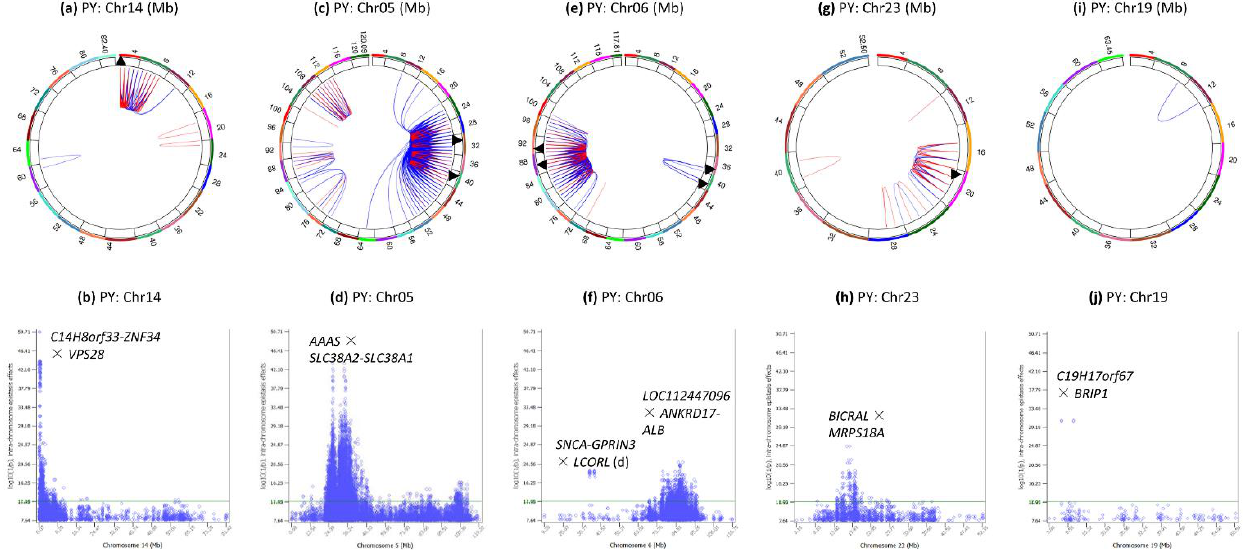
Figure 6. Chromosomes with most significant intra-chromosome epistasis effects for protein yield. The top row shows the circular plots with red color indicating intra-4 Mb epistasis effect and blue color indicating inter-4 Mb epistasis effects; the bottom row shows the Manhattan plots of log10(1/p) values, where p = the 5% genome-wide type-I error with the Bonferroni multiple testing correction. The black arrow indicates the location of the peak epistasis effect of the chromosome. Gene name indicates the gene with a peak SNP epistasis effect, and ‘ - ’ indicates the SNP was between the two genes. PY = protein yield. ( a ): Intra-chromosome epistasis effects of Chr14 for protein yield. ( b ): Statistical significance of intra-chromosome epistasis effects of Chr14 for protein yield. ( c ): Intra-chromosome epistasis effects of Chr05 for protein yield. ( d ): Statistical significance of intra-chromosome epistasis effects of Chr05 for protein yield. ( e ): Intra-chromosome epistasis effects of Chr06 for protein yield. ( f ): Statistical significance of intra-chromosome epistasis effects of Chr06 for protein yield. ( g ): Intra-chromosome epistasis effects of Chr23 for protein yield. ( h ): Statistical significance of intra-chromosome epistasis effects of Chr23 for protein yield. ( i ): Intra-chromosome epistasis effects of Chr19 for protein yield. ( j ): Statistical significance of intra-chromosome epistasis effects of Chr19 for protein yield.